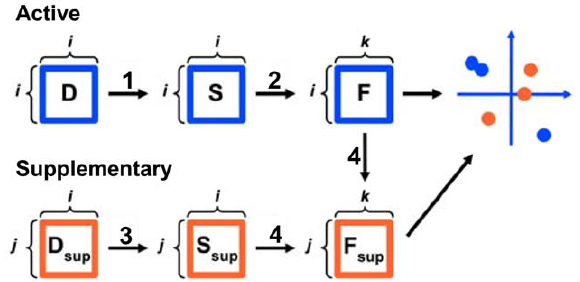
Figure 1. Schematic representation of the MDS analysis. The analysis of N active and N sup supplementary sequences are represented in blue and orange, respectively. D and D sup represent distance matrices, S and S sup cross-product matrices and F and F sup factor score matrices. The coordinate of the i th active sequence on the k th principal component is directly obtained from the i th element of the k th column of F . The coordinate of the j th supplementary sequence on the k th principal component of the active space is directly obtained from the j th element of the k th column of F sup . The numbers above the arrows refer to the equations given in the Methods section.